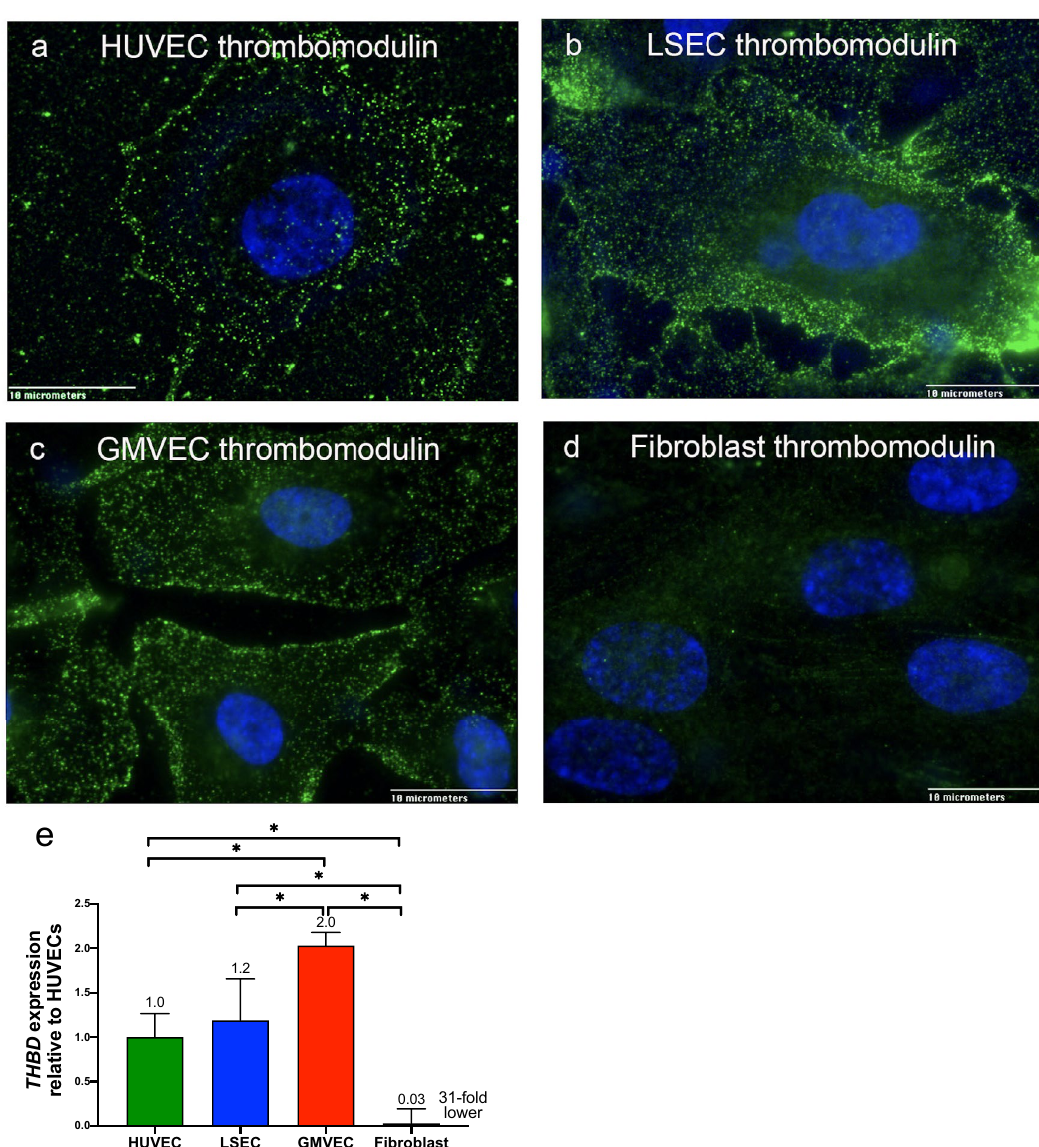
Figure 4. Immunofluorescent detection of thrombomodulin on surfaces of HUVECs, LSECS, GMVECs, and fibroblasts and THBD (thrombomodulin) gene expression. HUVECs ( a ), LSECs ( b ), GMVECs ( c ), and fibroblasts ( d ), were washed, treated with fixative, and stained with mouse anti-thrombomodulin + secondary goat anti-mouse IgG AF-488. The nuclei were stained with DAPI, and cells were imaged at 100X. Images were chosen from 10 to 30 microscopic fields using each cell type. ( e ) Expression levels of THBD in each cell type was quantified relative to THBD levels in HUVECs after normalization to GAPDH in each real-time PCR analysis. Data shown are means + SD from four to five separate RNA extractions for each cell type (HUVEC, n = 5, LSEC, n = 4, GMVEC, n = 4, fibroblast, n = 4). * p <